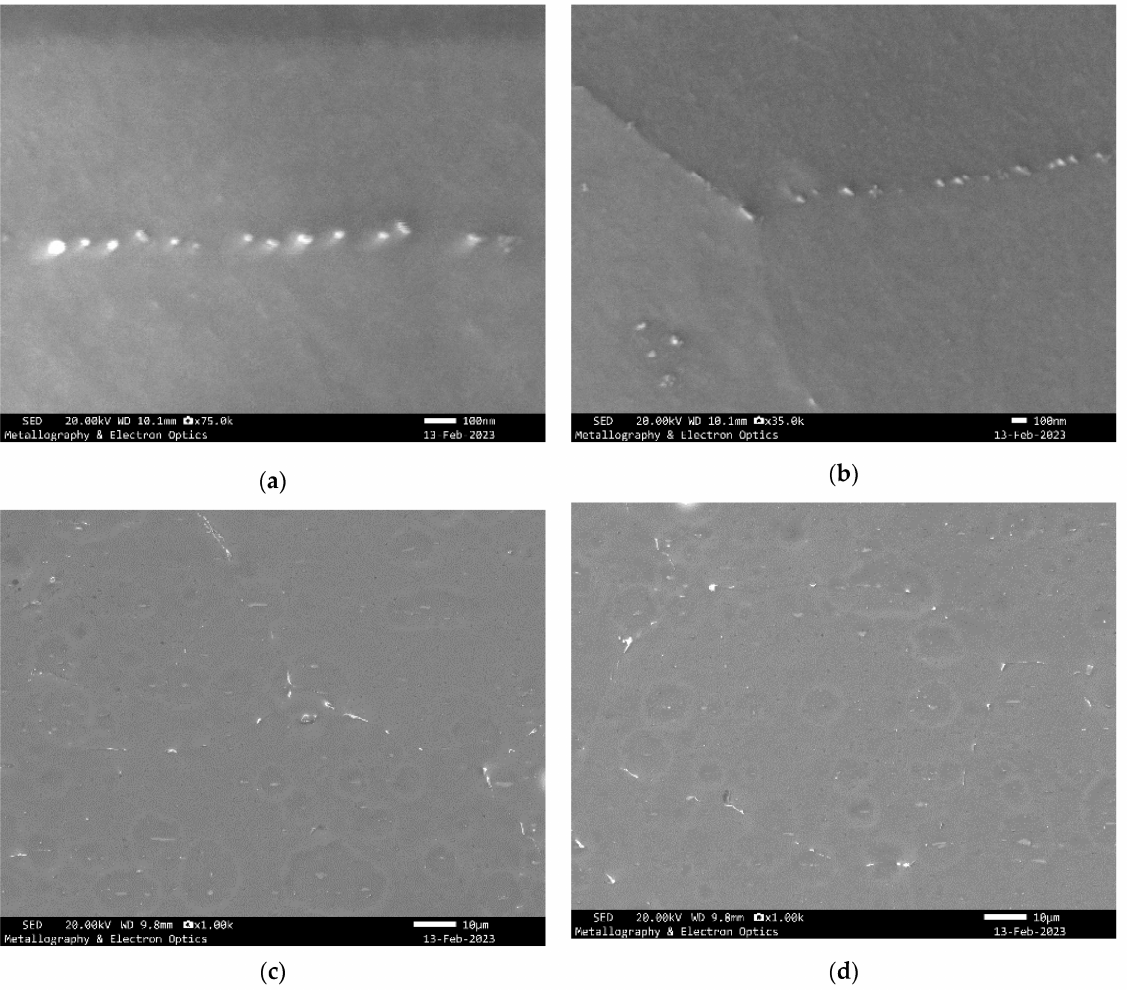
Figure 10. Indicative SEM micrographs indicating precipitation behavior on the WQ ( a , b ) and the AC ( c , d )